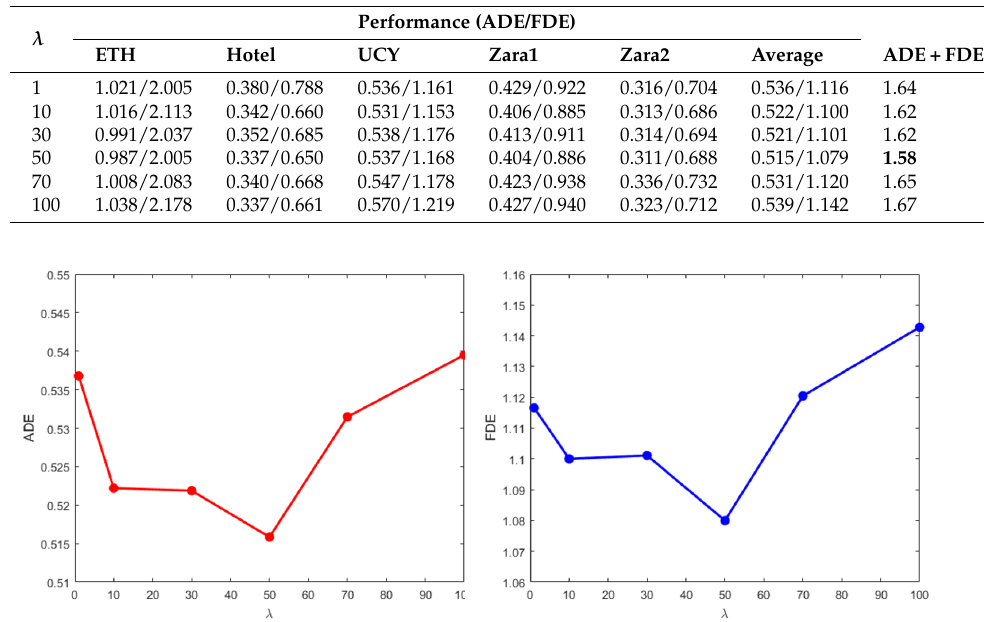
Table 5. Result comparison on ETH and UCY datasets with different values of the key parameter λ , which is used to keep the balance of the loss functions. λ is set to 50 in training.